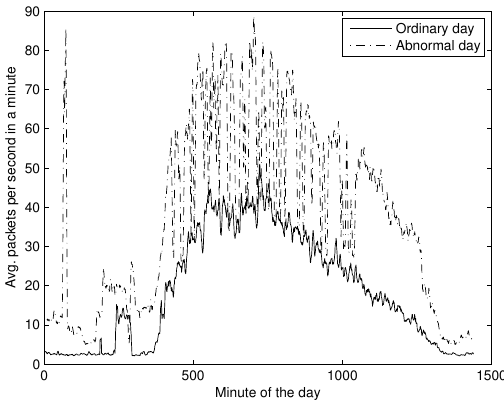
Figure 14. Average packets per second in a minute. The solid line stands for a typical day of DNS activity while the dashed line refers to abnormal